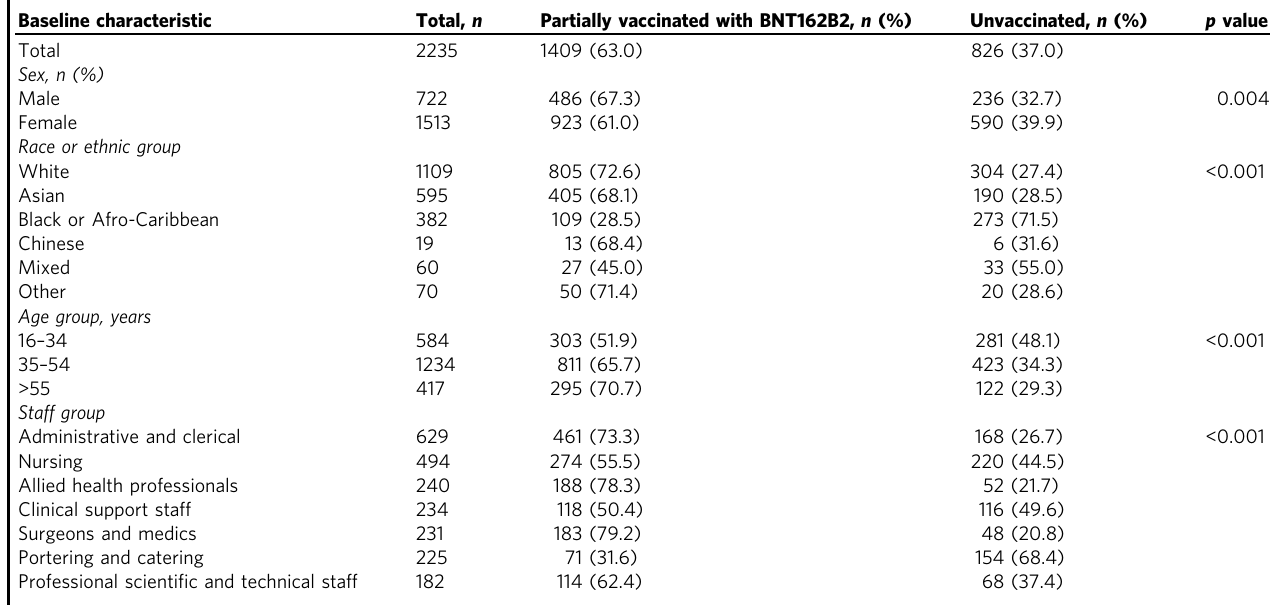
Table 1 Comparing baseline characteristics in partially vaccinated HCWs receiving single-dose BNT162b2 vaccine and unvaccinated groups.